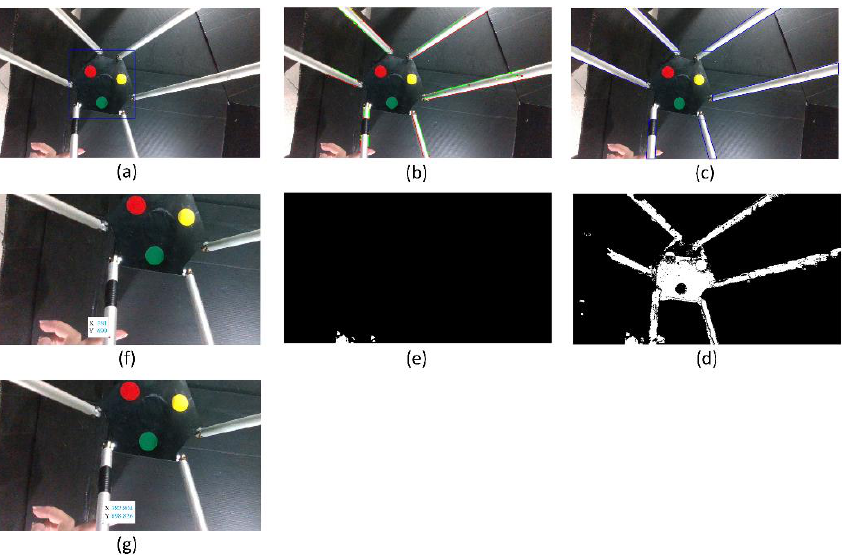
Figure 22. The collision isolation procedure in Case 3: ( a ) The bounding box around the active plate; ( b ) straight lines around rods; ( c ) the recognized rods; ( d ) objects in the workspace; ( e ) the external object; ( f ) potential contact points; ( g ) the contact point.